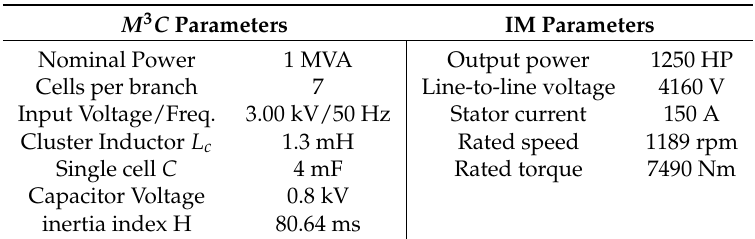
Table 5. Simulation parameters of the M 3 C and induction machine. Based on [31].